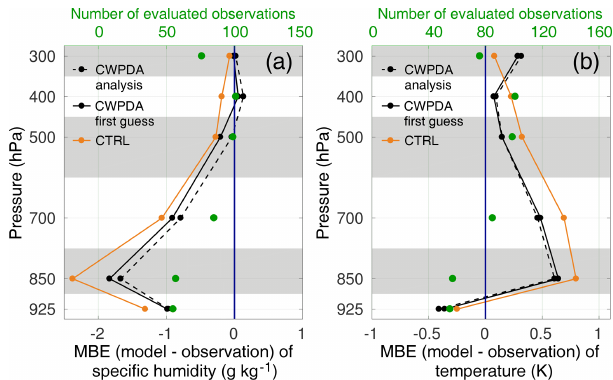
Figure 5. Vertical profiles of the MBE per bins of pressure for spe- cific humidity (a) and temperature (b) for the two experiments CW- PDA (black) and CTRL (orange), with respect to independent ra- diosonde observations. The solid lines show the ensemble mean first guesses. The dashed line shows the analyses of CWPDA. A dashed line does not exist for CTRL since prior and posterior are identical. The number of evaluated observations per pressure bin is shown in green. All cycling periods listed in Table 1, including 43 radiosoundings at 12:00UTC at Gillot-Aéroport, are